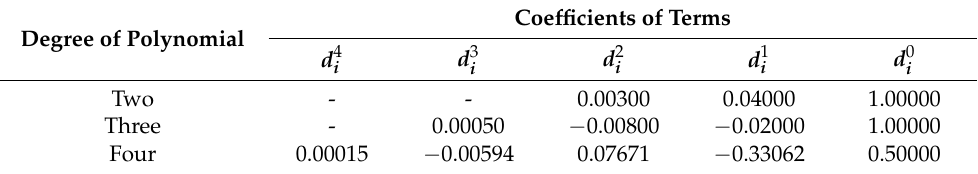
Table 1. Simulated coefficients of the polynomials.